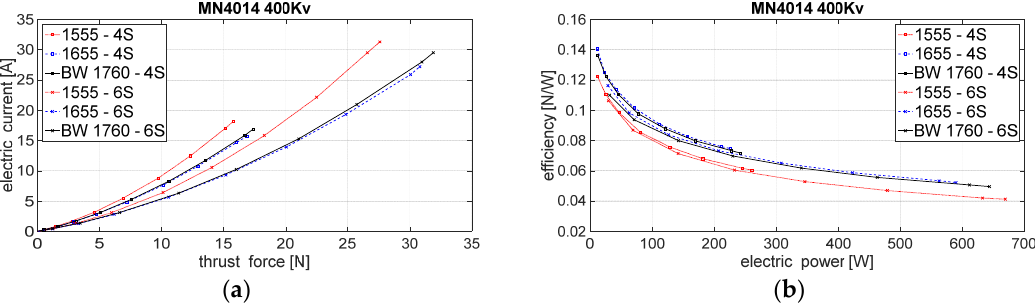
Figure 21. Energy consumption of MN 4014 BLDC motor: ( a ) electric current with respect to thrust force; ( b ) overall efficiency.